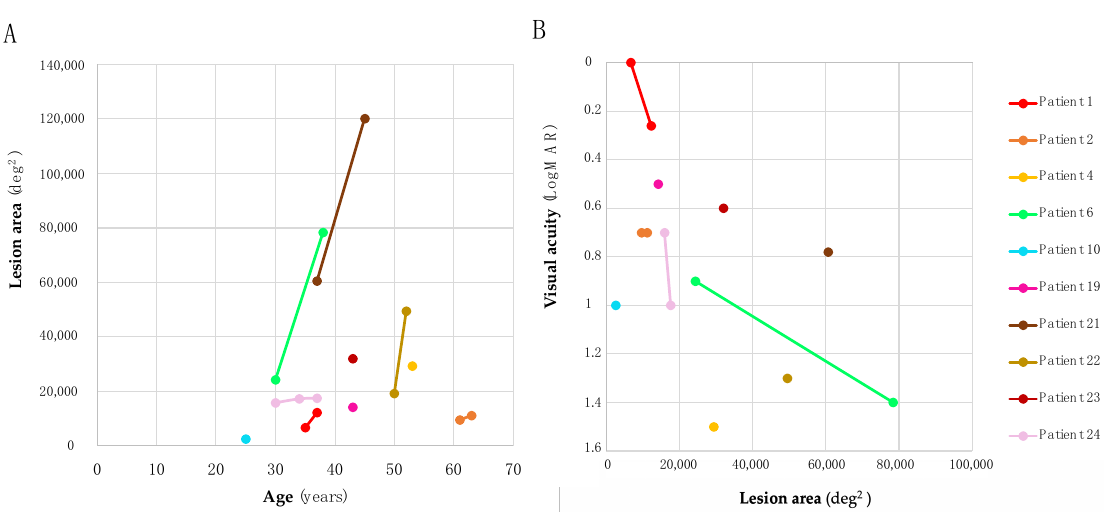
Figure 7. ( A ) The correlations between age and lesion area on fundus autofluorescence imaging. All patients with longitudinal imaging showed increases in lesion area with time. Note the relatively small lesion area size of Patient 2, harboring p.Met1? and p.Leu246Pro. ( B ) The correlations between lesion area and visual acuity on fundus autofluorescence imaging. Note the relatively large lesion area size and good visual acuity of Patient 21 at the age of 37 years. Visual acuity in this patient deteriorated to 1.3 LogMAR after 10 years, but his OCT images for evaluating the integrity of his photoreceptor layer are not available. On the other hand, Patient 4 had relatively small lesion area size and poor visual acuity (1.5 LogMAR). On OCT, the integrity of external limiting membrane was still preserved in this patient. Note that the colors of the patients are the same in Figures 5–8.